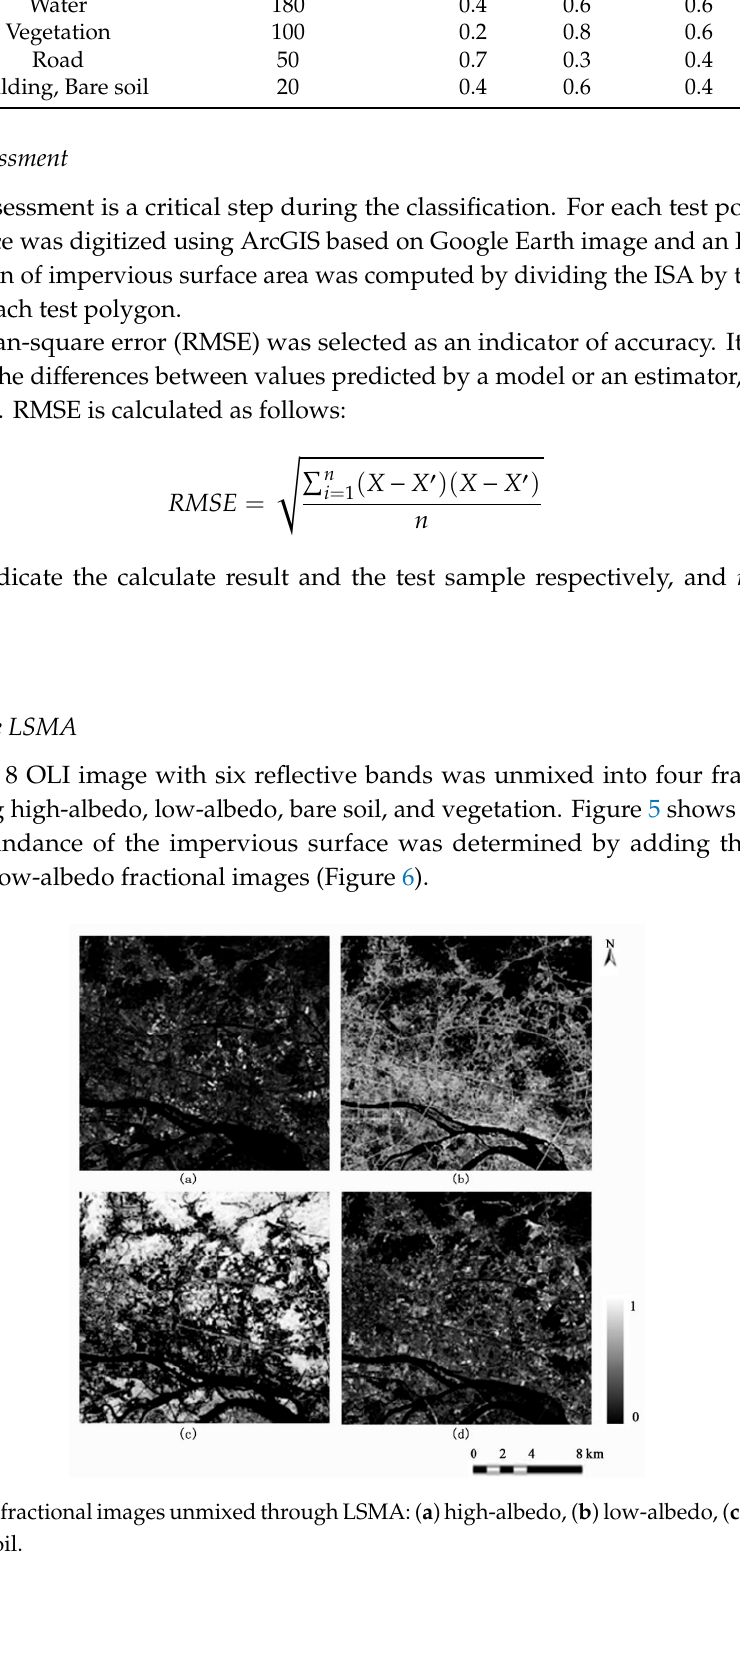
Figure 6. Abundance of the impervious surfaces.